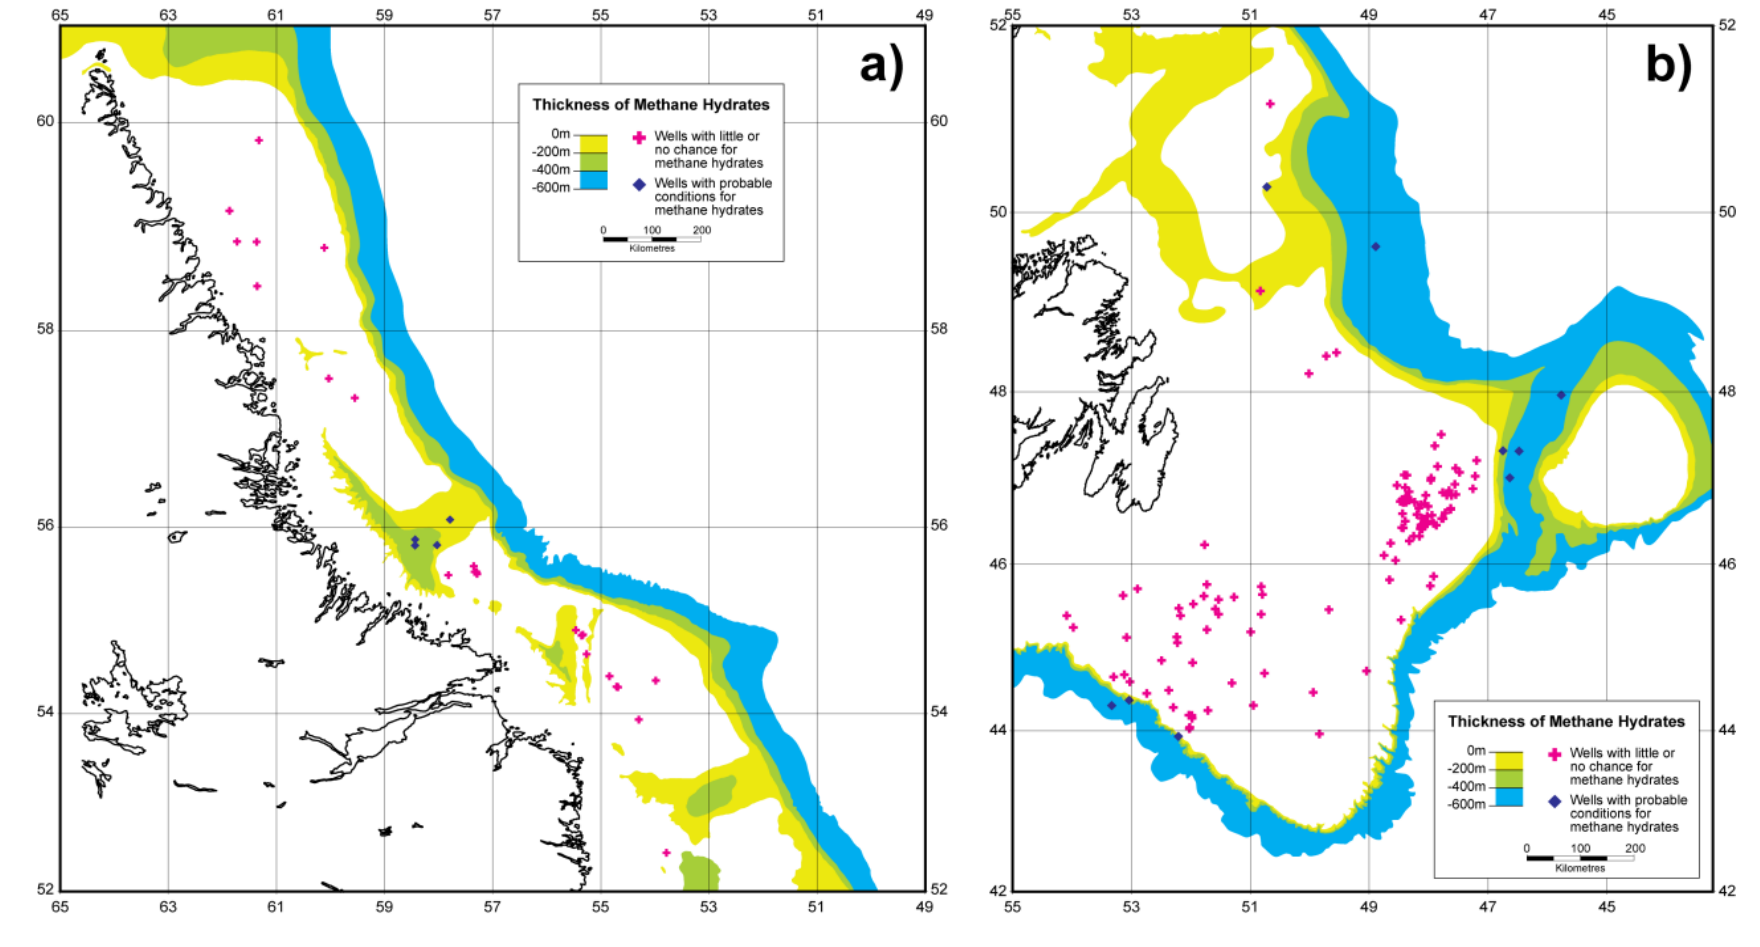
Figures 9. Predicted GH thickness for ( a ) offshore Labrador and ( b ) the Grand Banks region modified here from predicted previously